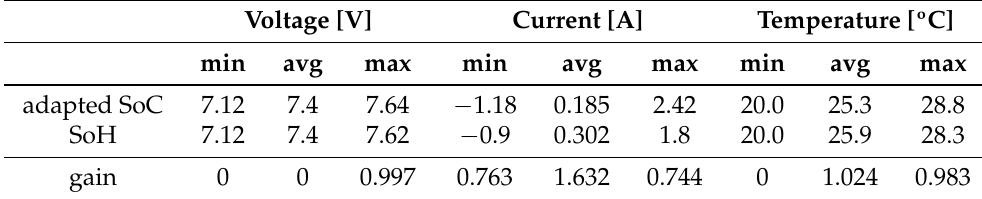
Table 12. Battery 3 during a month of simulation: Case 2.